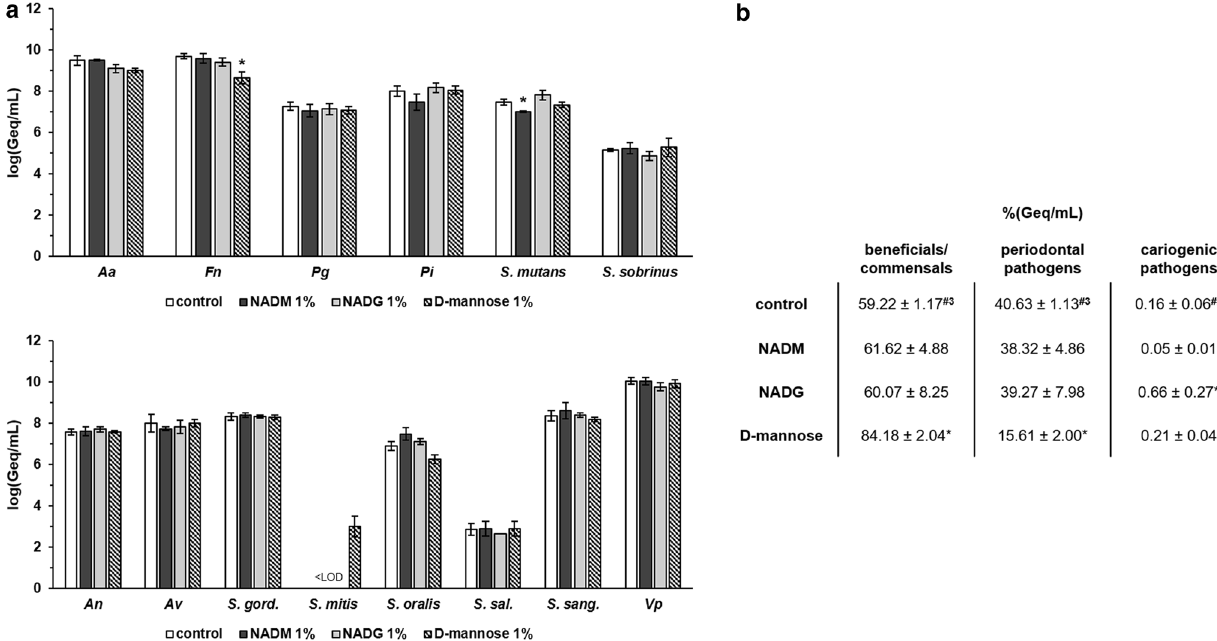
Figure 2. Comparison of the effects of repeated rinsing with NADM, NADG or d-(+)-mannose at ~ 0.05 M (1% (w/v) ) on multi-species biofilm composition. ( Panel a ) Absolute abundances of pathogenic oral species (upper graph) and beneficial/commensal oral species (lower graph) are shown as mean ± SD (n = 3) logarithmic values of the genome equivalents per millilitre (log(Geq/mL)). ( Panel b ) Relative abundances of the different groups (beneficial/commensals, periodontal pathogens, cariogenic pathogens) of bacterial species are shown as mean ± SD (n = 3) percentage of the genome equivalents per millilitre (%(Geq/mL)). All substrates were dissolved in PBS at a concentration of ~ 0.05 M (1% (w/v) ) (corresponding molar concentrations: 0.045 M (NADM and NADG) and 0.056 M (d-(+)-mannose)). Statistically significantly different values when compared to the control (PBS) are marked with ‘ * ’ ( P < 0.05 ANOVA + Dunnett’s correction for simultaneous